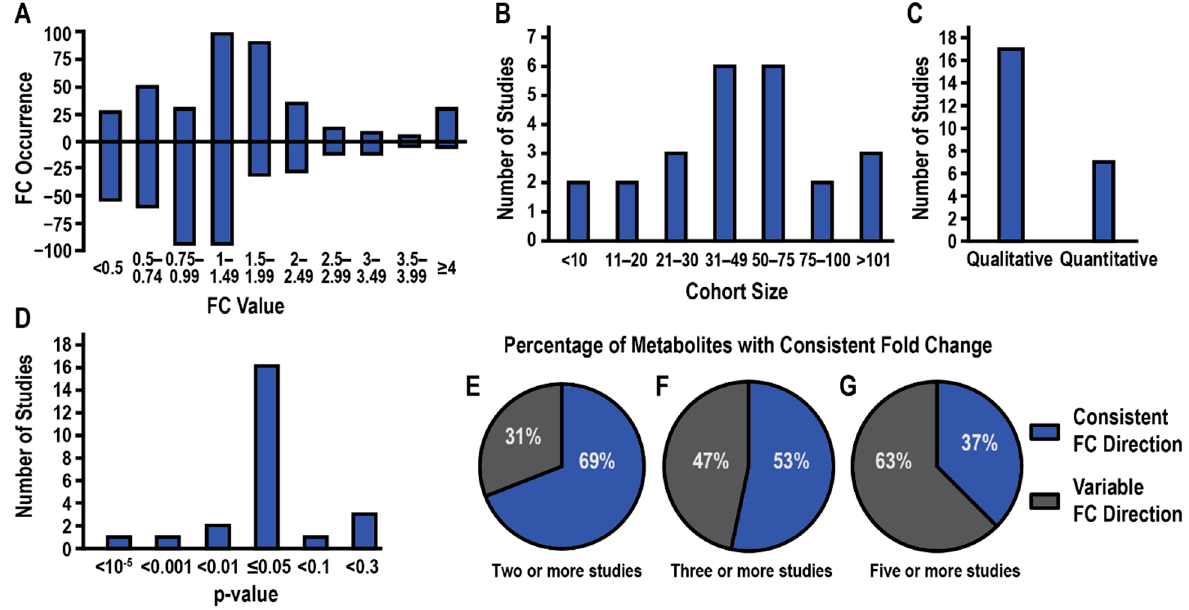
Figure 3. Summary of Experimental Parameters, Design, and Outcomes. ( A ). Bar chart showing the distribution of FC values across the 24 studies. A value greater than one indicates a relative increase in the metabolite in PDAC while a value less than one indicates a relative decrease in the metabolite in PDAC. ( B ). Bar chart showing the distribution of cohort size across the 24 studies. ( C ). Bar chart depicting the number of studies that reported a quantitative or qualitative metabolite fold change. ( D ). Bar chart showing the distribution of p -value used to define a statistically significant metabolite change. One study did not report a p -value. Pie charts summarizing the consistency in reported fold change direction (increase or decrease) for metabolites identified in ( E ). two or more studies, ( F ). three or more studies, or ( G ). five or more studies. Blue indicates percentage of metabolites with the same fold change direction in all studies and gray indicates percentage of metabolites with variable fold change directions.